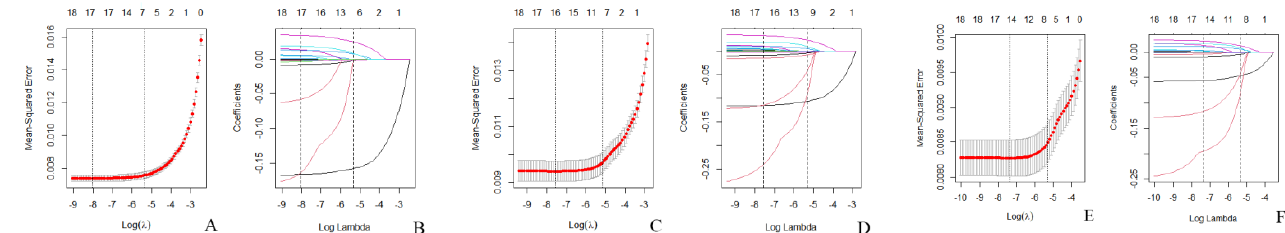
Figure 2. Variables selection using Lasso regression in NHANES 2015-2018. ( A ) Lasso coefficient of 18 variables in left arm BMD; ( B ) the optimal penalty coefficient ( λ = 0.00032) in the Lasso re- gression was identified with the minimum criterion; ( C ) Lasso coefficient of 18 variables in left leg BMD; ( D ) the optimal penalty coefficient ( λ = 0.00052) in the Lasso regression was identified with the minimum criterion; ( E ) Lasso coefficient of 18 variables in total BMD; ( F ) the optimal penalty coefficient ( λ = 0.00065) in the Lasso regression was identified with the minimum criterion). Table 2. Results of quantile regression coefficients.